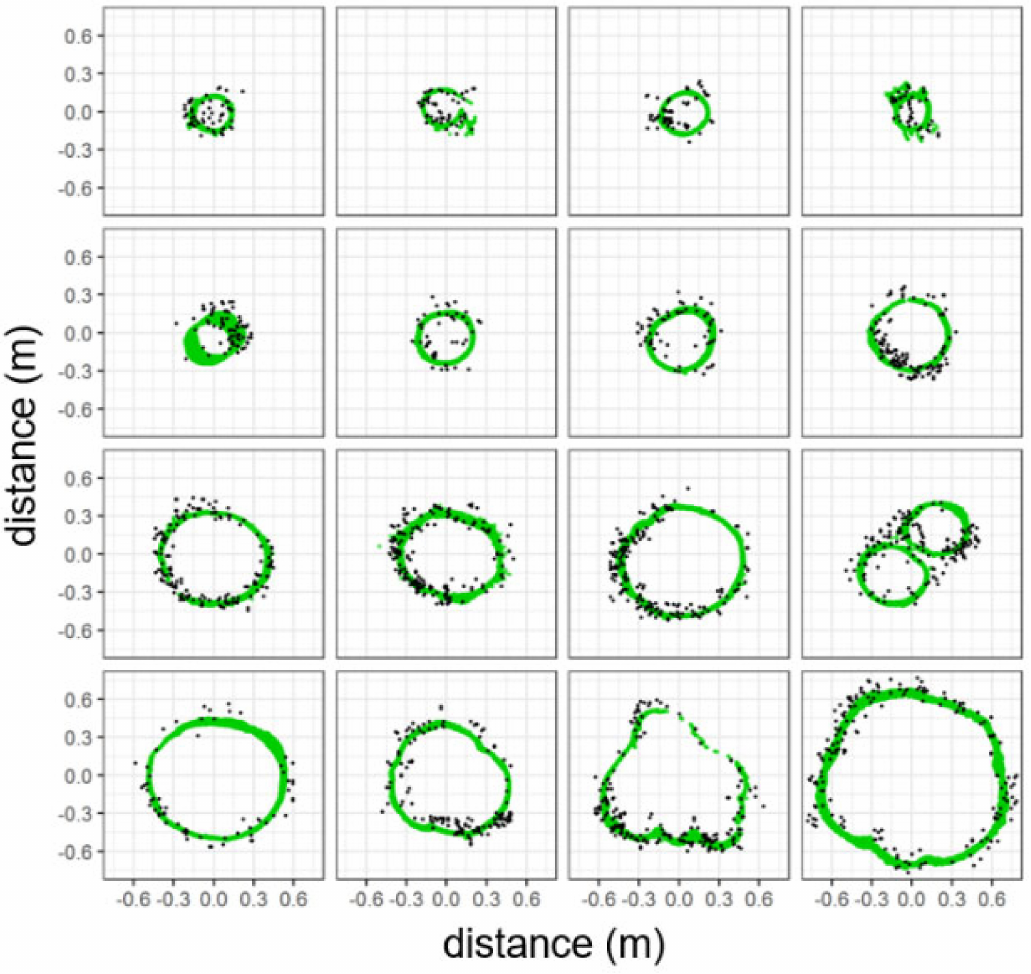
Figure 4. Representative comparisons between drone lidar (black points) and TLS (green points) within 20 cm vertical slices 1.1–1.3 m